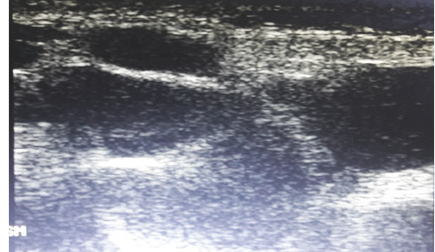
Figure 2: Ultrasound scan of the neck; multiple enlarged cervical lymph nodes at the levels of I-B, II, III, and IV. Largest at level II was 3.7 cm × 2.0 cm in